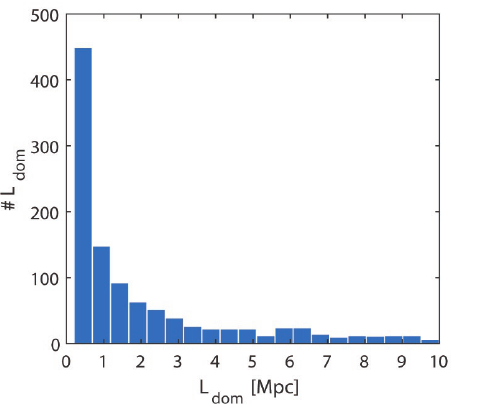
Figure 16. Number of domains as a function of their size in the case z = 0.5. (Credit